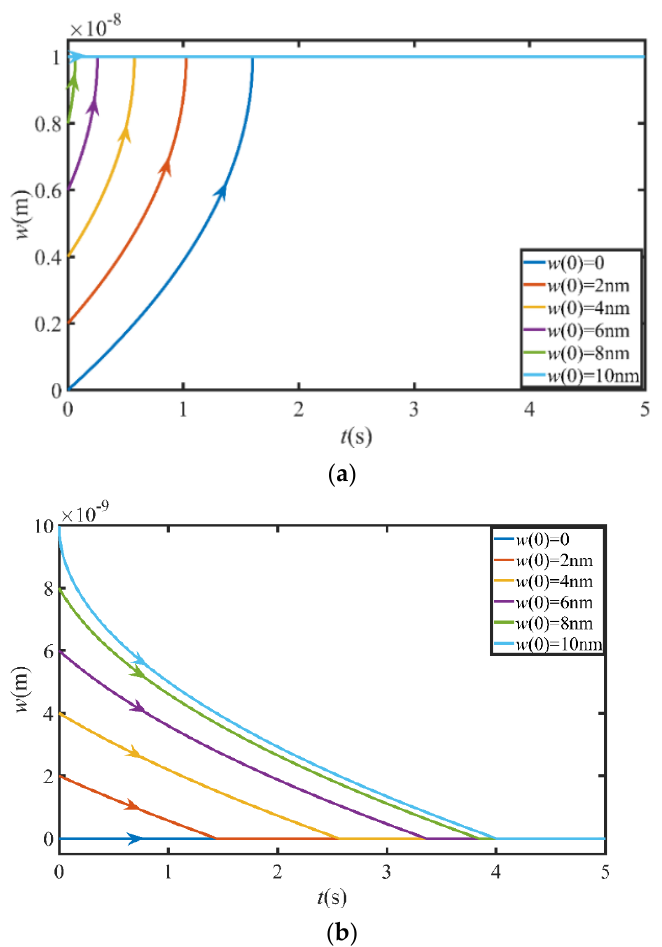
Figure 5. DC response diagram of the memristor, according to Equation (15). ( a ) Under a posi- tive voltage v m = 0.5 V, the responses of initial values w ( 0 ) ∈ { 0, 2 nm,4 nm,6 nm,8 nm,10 nm } are obtained. ( b ) Under a negative voltage v m = − 0.2 V, the responses of initial values w ( 0 ) ∈ { 0, 2 nm,4 nm,6 nm,8 nm,10 nm } are